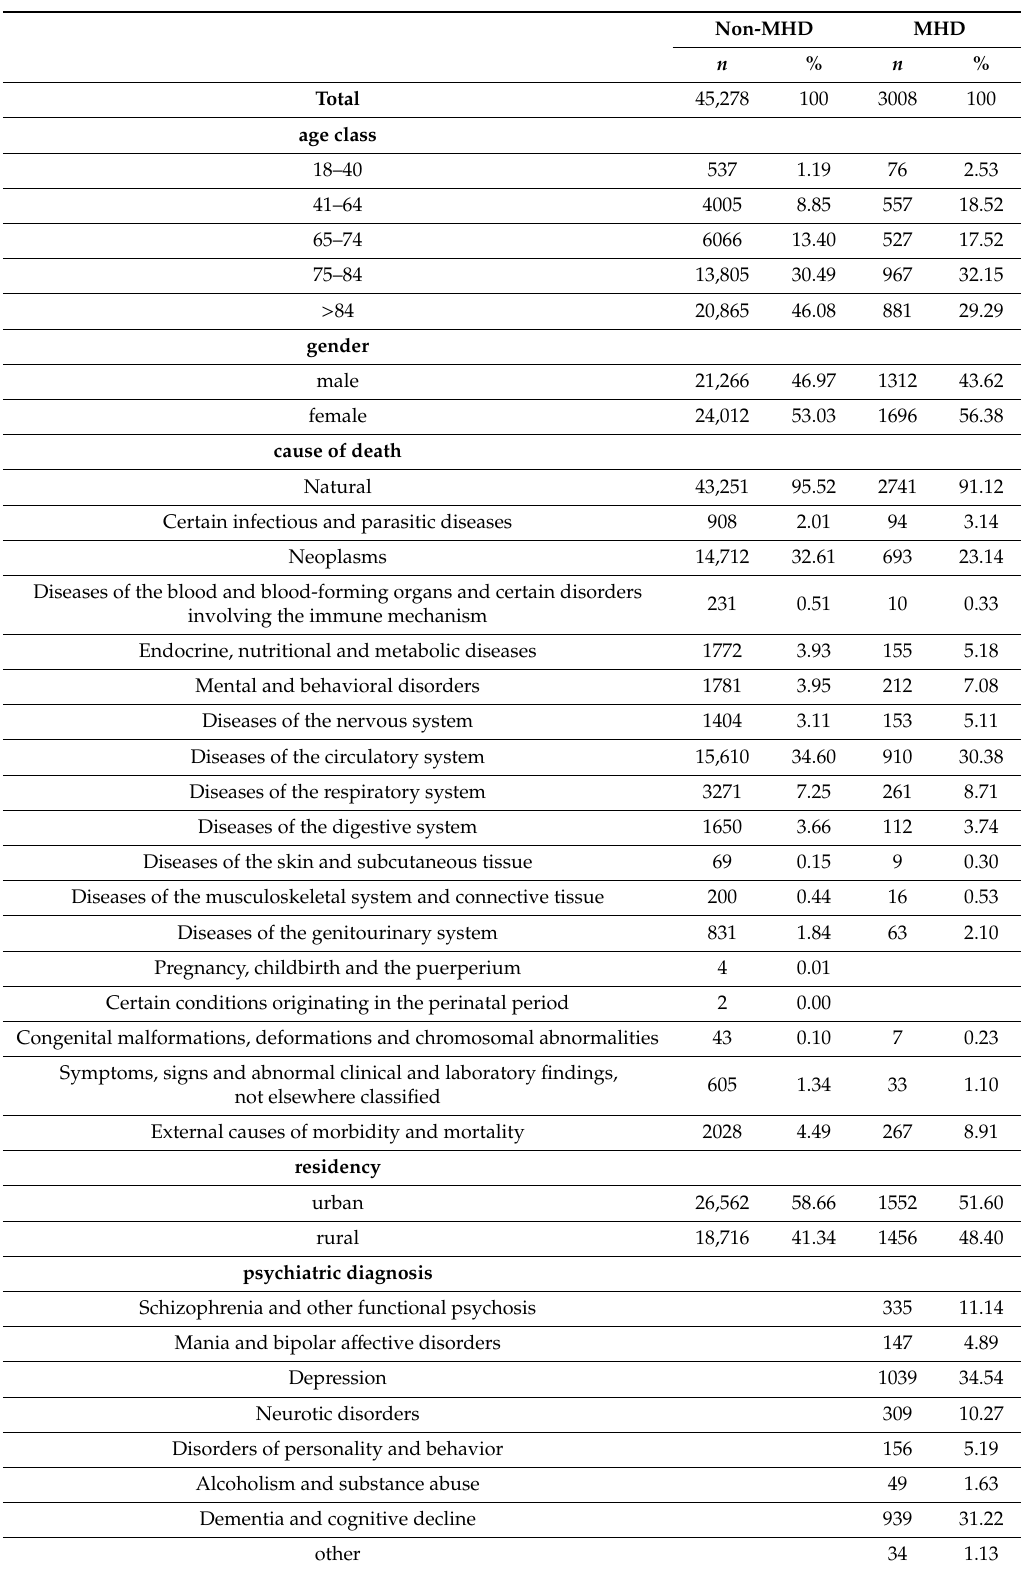
Table 2. Characteristics of the study populations by demographic characteristics, specific cause of death and psychiatric